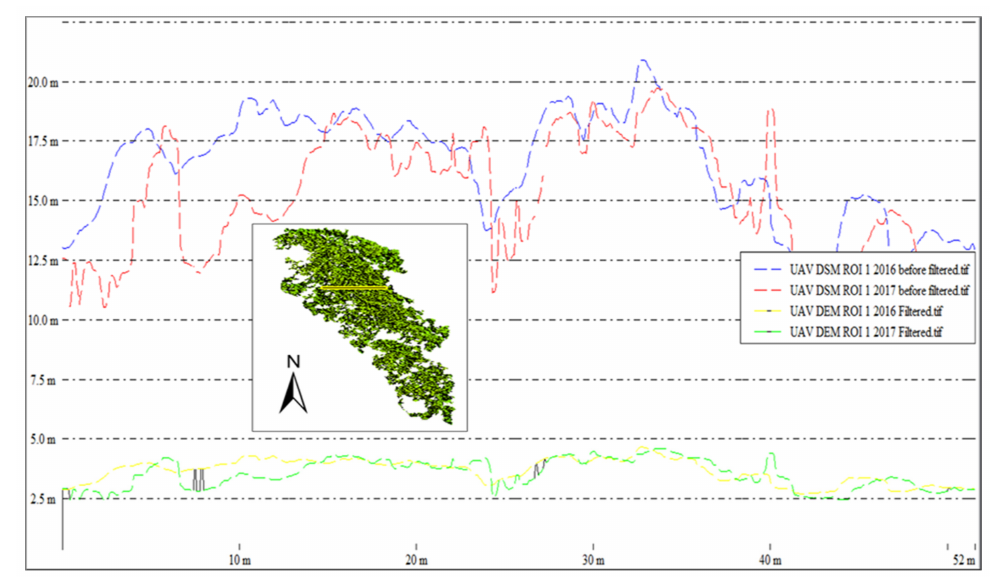
Figure A8. Average height comparison between filtered and unfiltered for ROI 1.